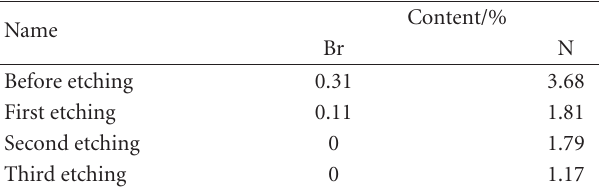
Figure 4: XPS wide scan spectra of samples, TDN and TNB. Table 1: Results of XPS analysis using Ar etching, sample TNB.